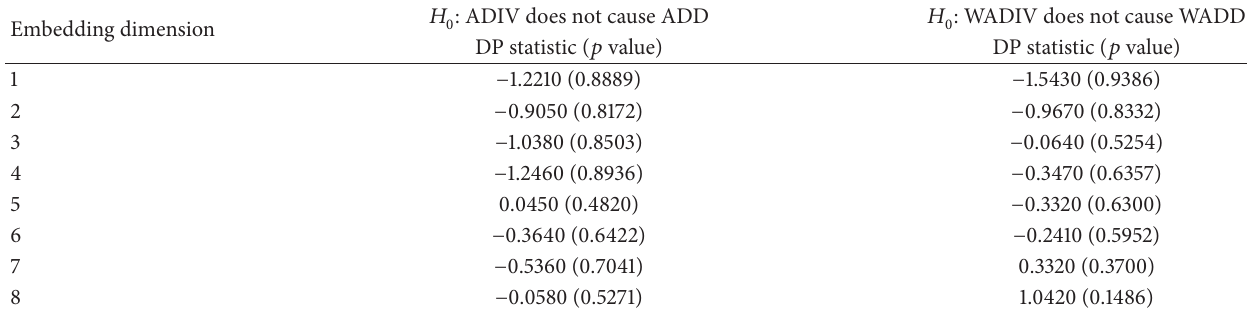
Table 4: Nonlinear Granger causality